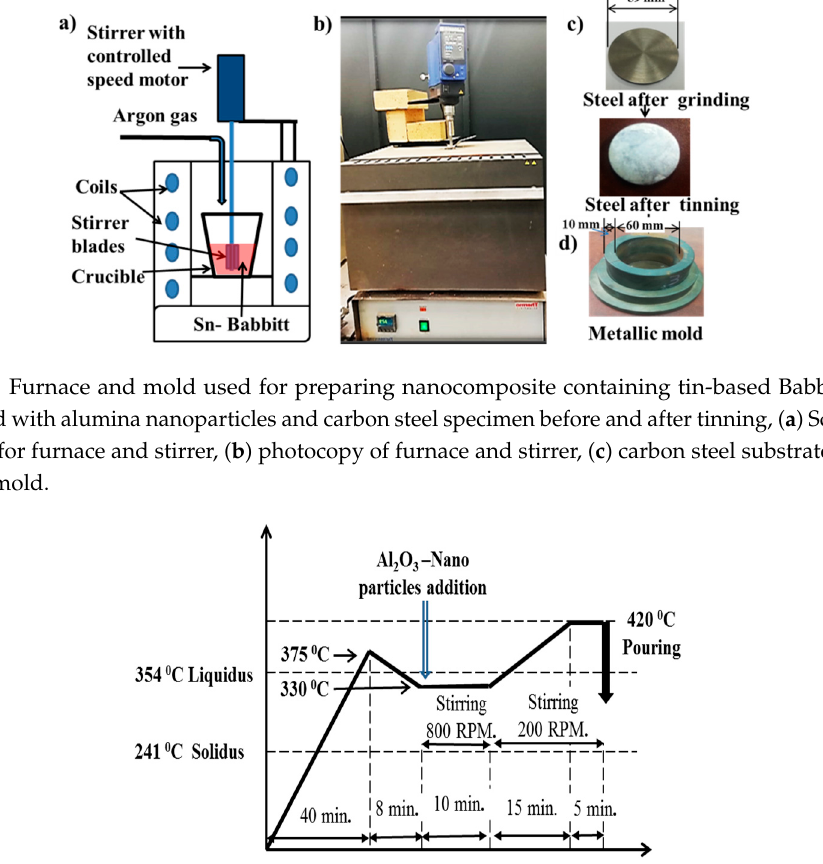
Figure 2. Sequence of preparing nanocomposite of tin-based Babbitt alloy reinforced with alumina nanoparticles by stir-casting process.